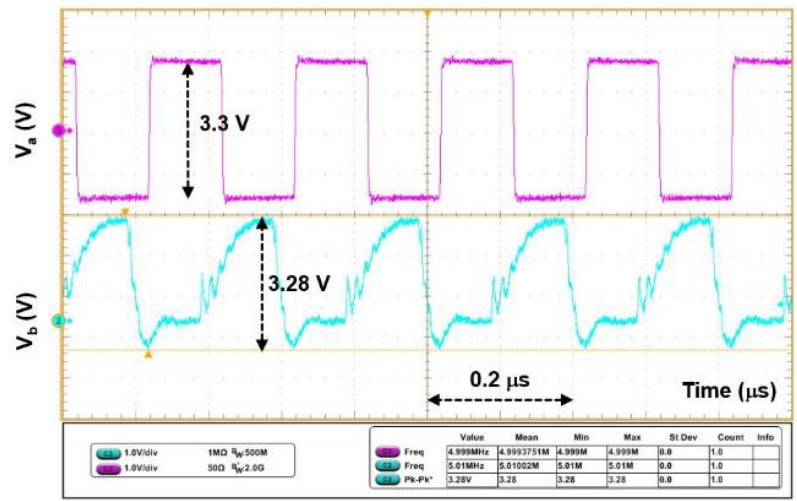
the proposed PLL. The magnitudes of the input signal V a and the feedback signal V b are